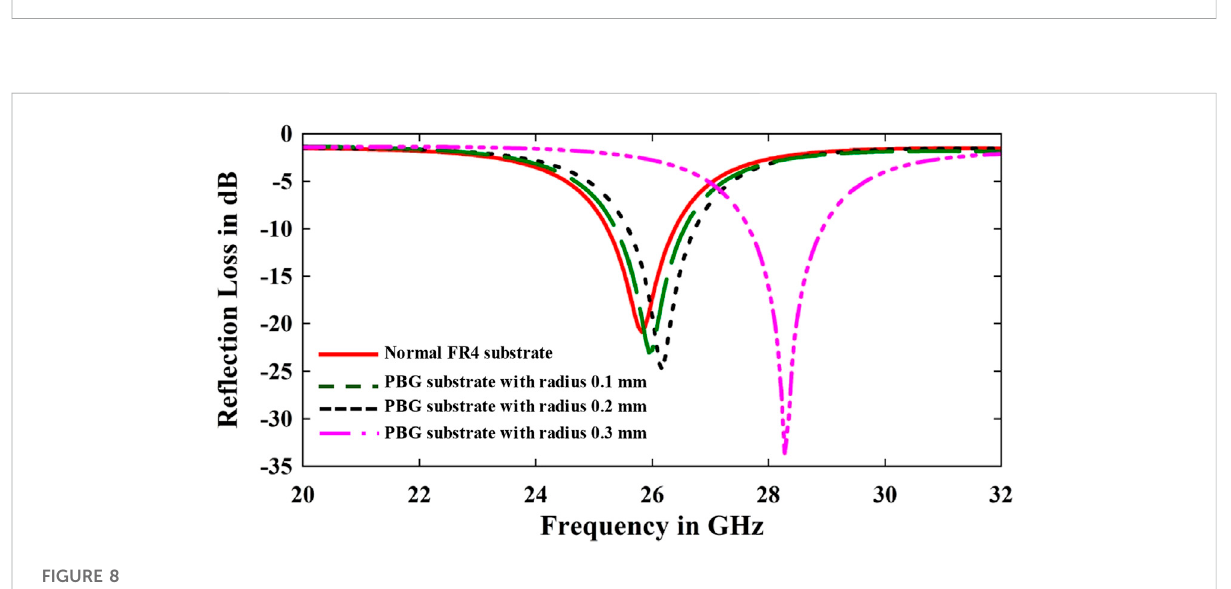
FIGURE 8 Simulated return loss with varying cylindrical